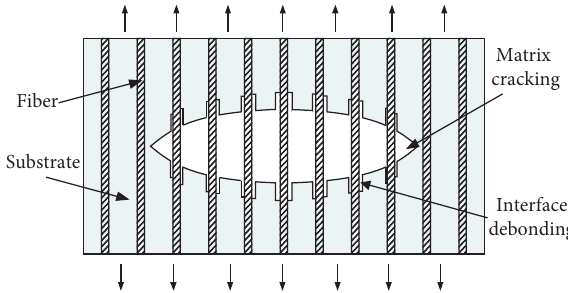
Figure 17: Mechanism of interfacial debonding and matrix cracking of fiber reinforced resin matrix composites